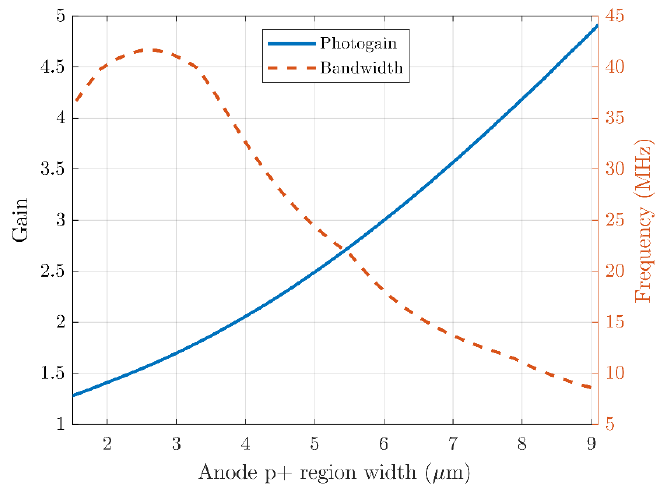
Figure 7. The simulated photo-gain and bandwidth for varying anode p + region cross-section widths. The width can be used to trade bandwidth for photo-gain.